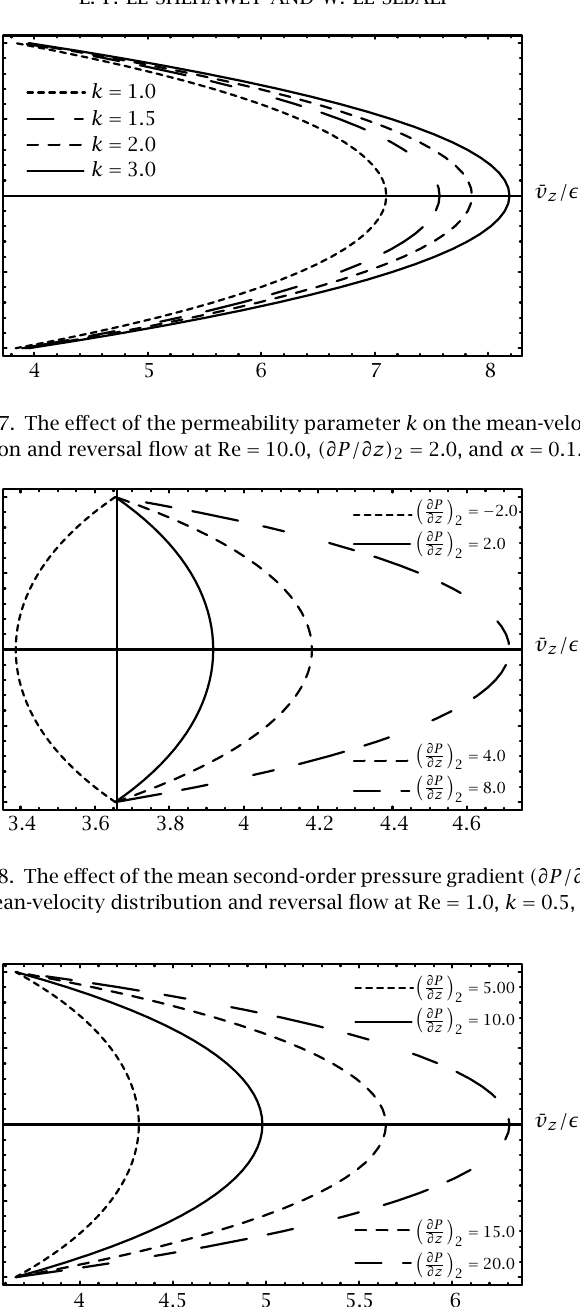
Figure 6.9 . The effect of the mean second-order pressure gradient (∂P/∂z) 2 on the mean-velocity distribution and reversal flow at Re = 1 . 0, k = 0 . 5, and α = 0 .